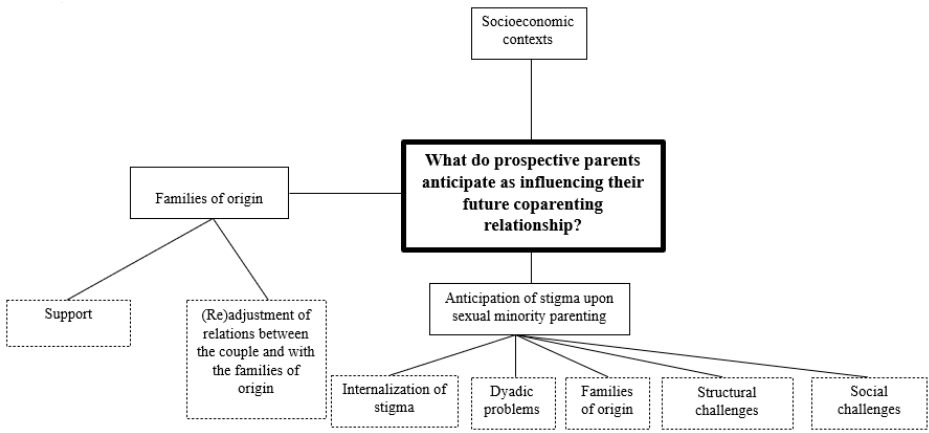
Figure 2. Thematic map of the themes obtained through cognitive interviews regarding prospective coparenting relationship.